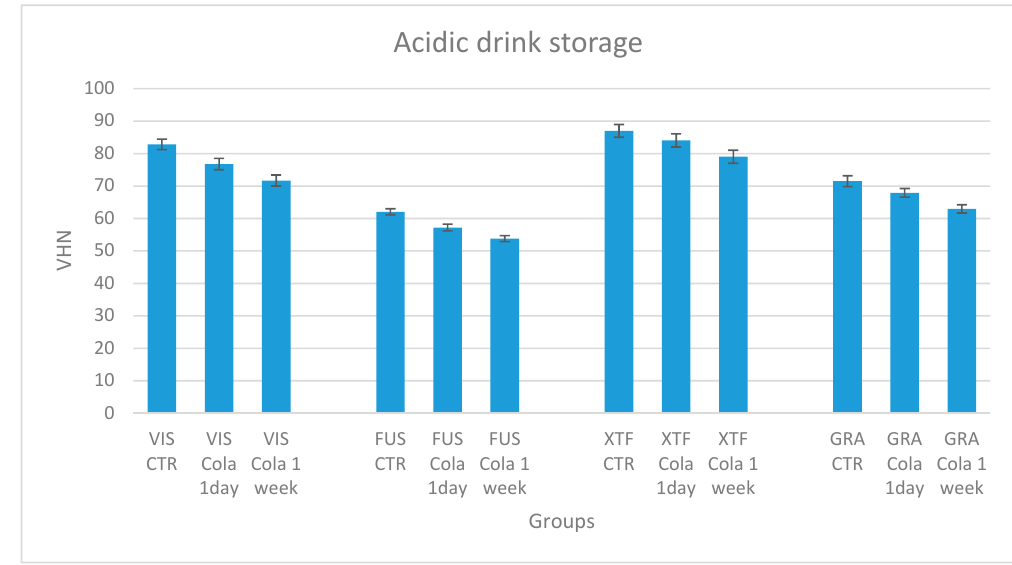
Figure 3. Mean Vickers hardness number and standard deviation for each tested material, considering the two di ff erent acid storages compared to a subgroup of control. Table 6. Mean percentage micro-hardness loss for the tested materials between di ff erent immersion